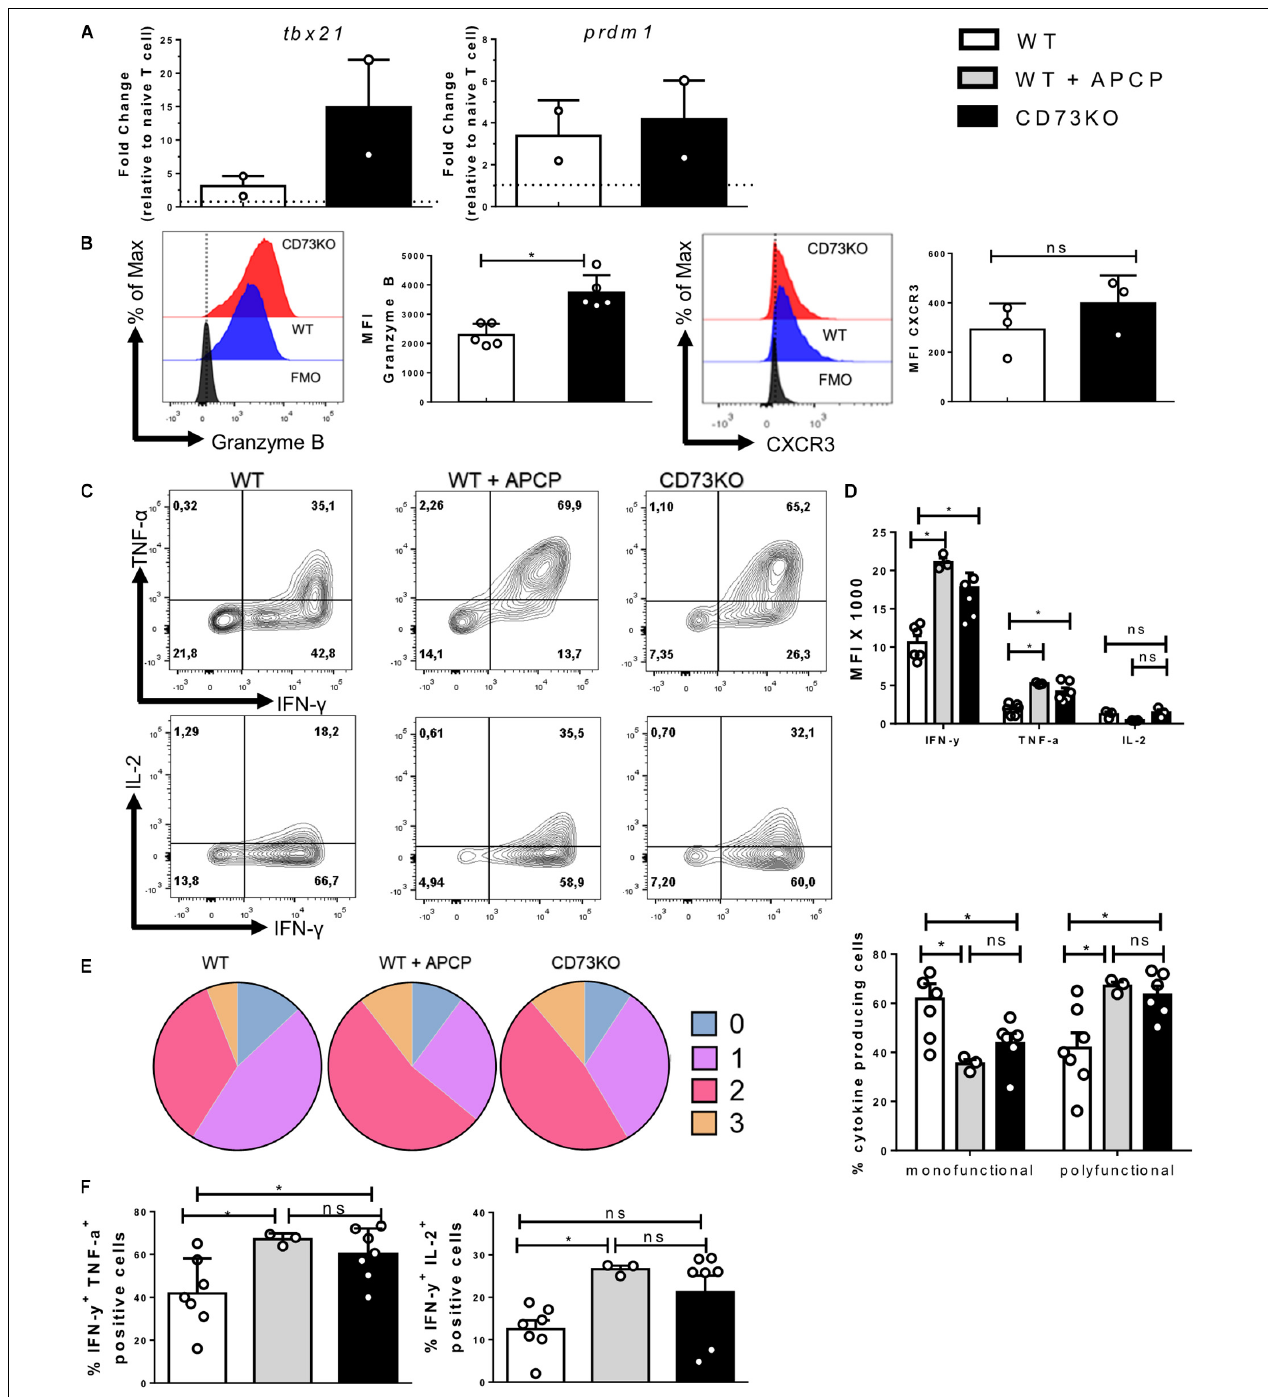
FIGURE 3 | CD73 limits the acquisition of the Tc1 effector program. Naive CD8+ T cells from WT mice were isolated and activated with soluble α -CD3/CD28 antibodies for 3 days in vitro in the presence of IL-2 (10 ng/ml) for the generation of Tc1 lymphocytes. Transcription factors, cytotoxic proteins, and cytokine production by Tc1 cells were evaluated by real-time PCR and FACS. (A) Expression of prdm1 and tbx21 was measured by real-time PCR ( n = 2). (B) Left, Representative histogram showing granzyme B production ( n = 5). Right, histogram depicting CXCR3 expression ( n = 3). (C) Representative dot plots showing TNF- α , IFN- γ , and IL-2 production by CD73KO and WT CD8+ T cells in the presence and absence of CD73 enzymatic activity inhibitor APCP (50 µ M) ( n = 3–7). (D) Bar graph showing the MFI for IFN- γ , TNF- α , and IL-2. (E) Left, graph showing the frequency of Tc1 cells that produce 0, 1, 2, and 3 cytokines. Right, frequencies of Tc1 cells producing up to one cytokine (mono-functional) or more than two cytokines (poly-functional). (F) Bar graphs showing the percentage of cells that produce IFN- γ and TNF- α or IFN- γ and IL-2. Two-tailed Mann–Whitney test and Kruskal–Wallis Test, * p < 0.05. Data is presented as the mean ± SEM.